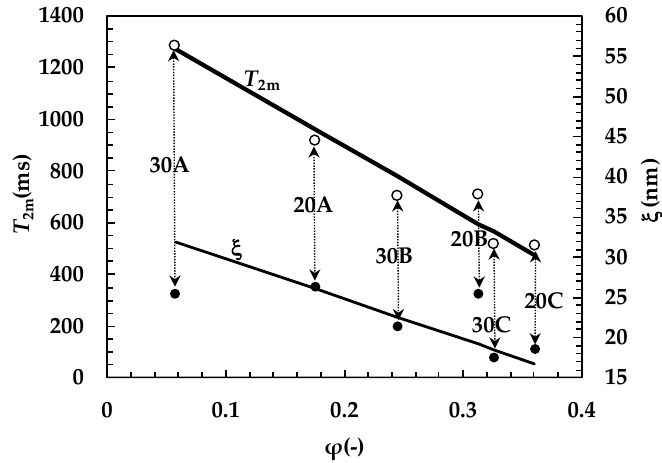
Figure 3. Dependence of the mean relaxation time of water hydrogens ( T 2m ) and mesh size ( ξ ) on the polymer volume fraction, φ , referring to the different hydrogels considered (20A, 20B, 20C, 30A, 30B, and 30C). Solid lines indicate the linear interpolation of the experimental data.